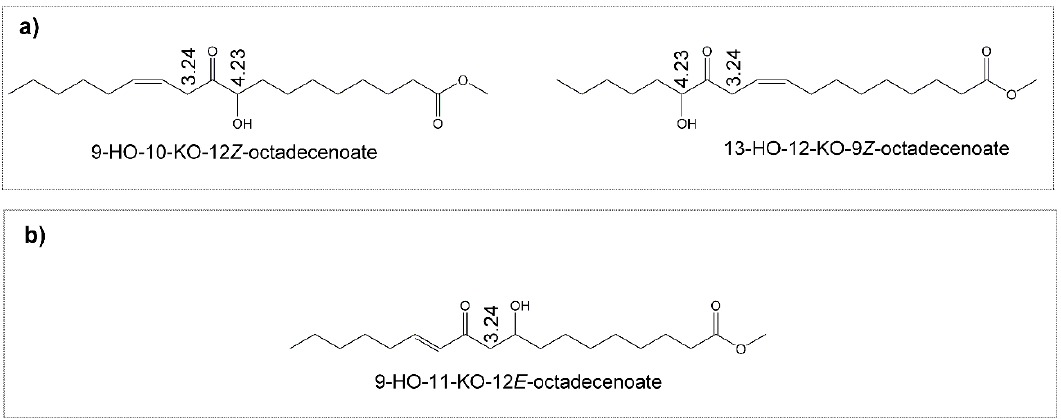
Figure 6. ( a ) Pathways of formation of hydroxy-epoxy-monoenes (HO-EPO-mEs) proposed by some authors under certain oxidation conditions [62,65] for ( a 1 ) mHO-EPO-mEs having the double bond between the epoxy and hydroxy groups together with some chemical shifts (ppm) of the 1 H NMR signals of some of their hydrogen atoms; ( a 2 ) mHO-EPO-mEs having hydroxy and epoxy group vicinal together with some chemical shifts (ppm) of the 1 H NMR signals of some of their hydrogen atoms. ( b ) Evolution of the concentration, expressed as mmol / mol TG versus time given in days of: 9-HO-12,13- E -EPO-10 E -octadecenoate + 13-HO-9,10- E -EPO-11 E -octadecenoate + 13-HO-9,10- Z -EPO-11 E -octadecenoate ( ♦ ); threo -11-HO-12,13- E -EPO-9 E -octadecenoate + threo -11-HO-9,10- E -EPO-12 E -octadecenoate (*).